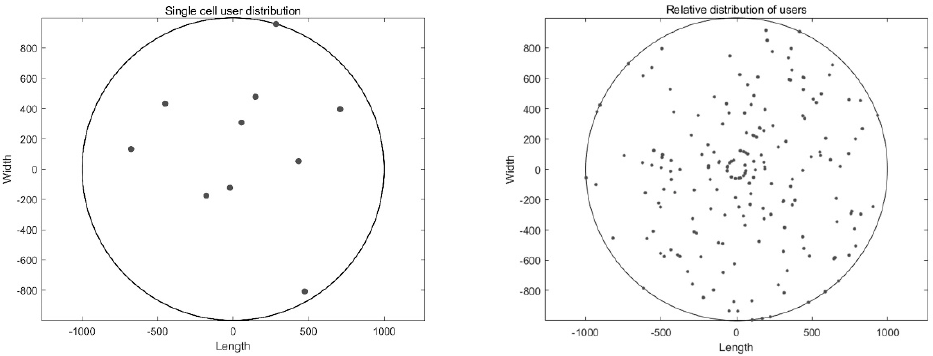
Figure 3. Distribution of users in a single cell and Relative distribution of all users in the area.